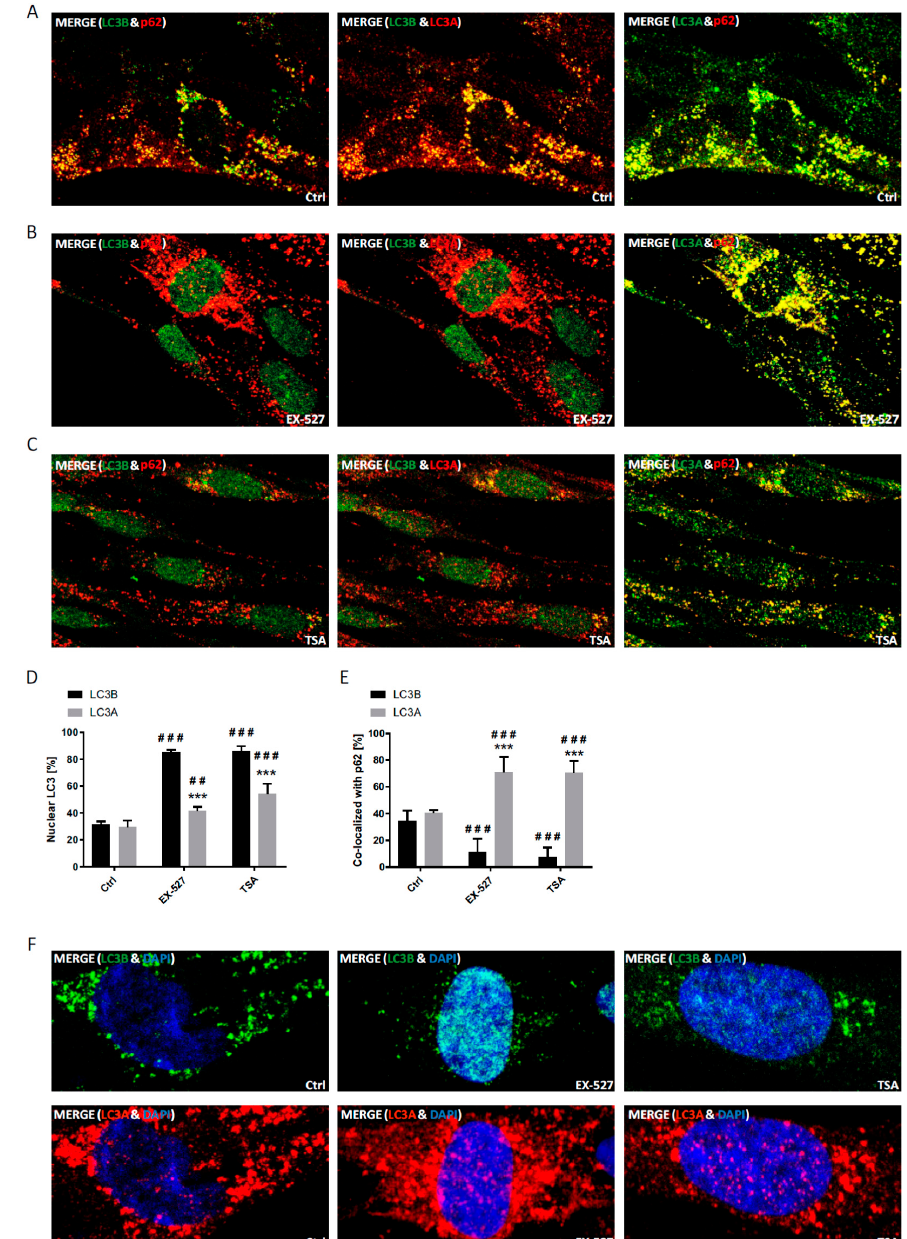
Figure 3. Analysis of the cellular localization of LC3A and LC3B in response to pharmacological sirtuin inhibition. Primary human fibroblasts treated with BafA1, Ex527 or TSA as indicated were immunostained with LC3A, LC3B and p62 antibodies and analyzed microscopically. ( A ) Cellular localization of LC3A, LC3B and p62 after treatment with BafA1 alone. ( B ) Cellular localization of LC3A, LC3B and p62 after treatment with Ex527 and BafA1. ( C ) Cellular localization of LC3A, LC3B and p62 after treatment with TSA and BafA1. ( D ) Image analytical quantification of the relative nuclear fraction of LC3A and LC3B in cells treated as indicated and counterstained with DAPI. Significant changes (by two-way ANOVA) versus the control: ## p ≤ 0.01; ### p ≤ 0.001; significant changes between the LC3s: *** p ≤ 0.001. ( E ) Relative co-localization of LC3A and LC3B with p62 quantified by image analysis. Statistical analysis was done as in D. Data in ( D ) and ( E ) were derived from three photographed, independent experiments ( n = 3), in which 10–50 cells per image were analyzed. ( F ) Magnified images of cells immunostained for LC3A or LC3B including the chromatin counterstain